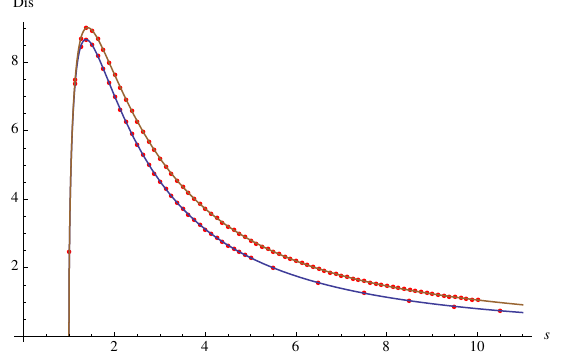
Figure 23 . We compare our Gegenbauer sum expression in eq. (D.4), truncating at ‘ = 10 , with the explicit discontinuity in eq. (D.8). We’ve normalized s at s = 1 to ∞ . We’ve compared the result of eq. (D.4), in red dots, to eq. (D.8) which is the colored curve. The brown curve is for cos θ = 1 perfect